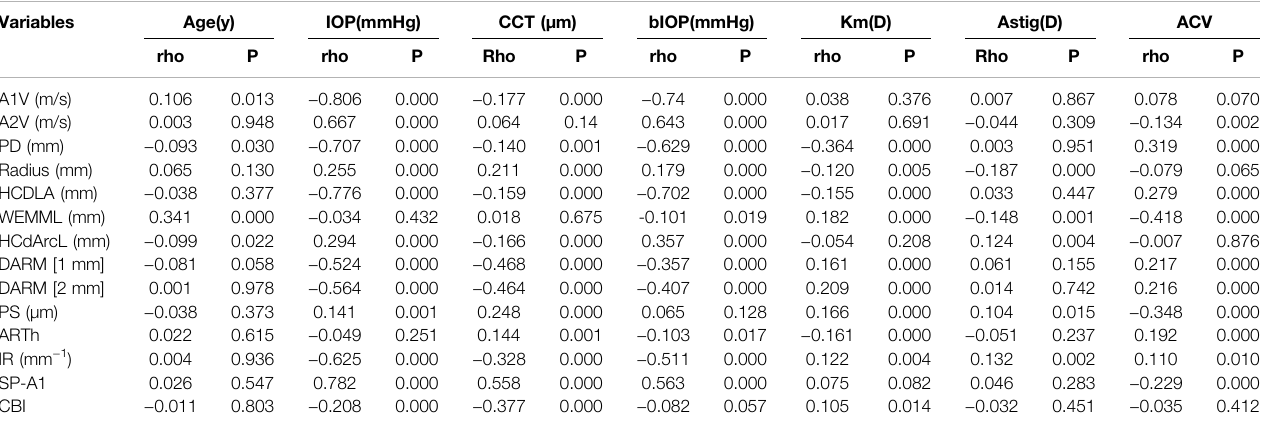
TABLE 5 | Correlation of demographics/ocular characteristics and corneal biomechanical parameters.